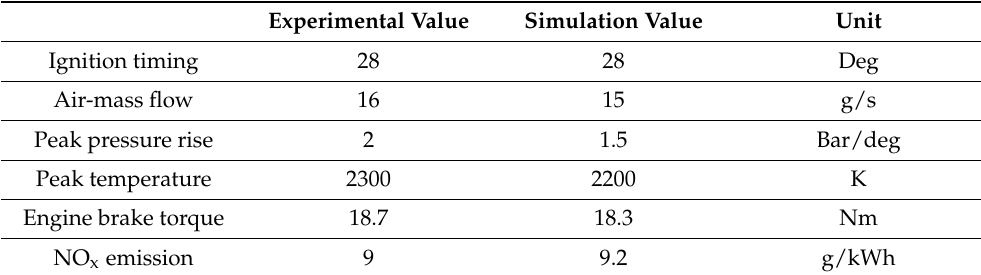
Table 2. The validation